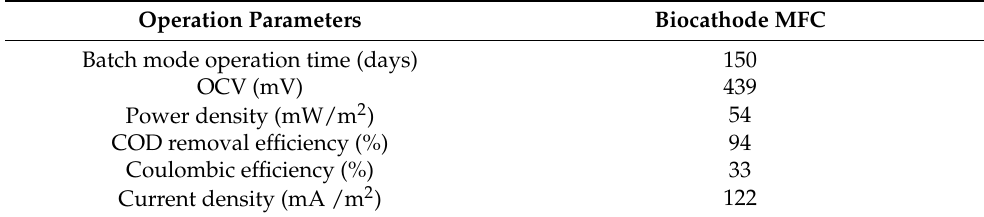
Table 3. Biocathode MFC operating